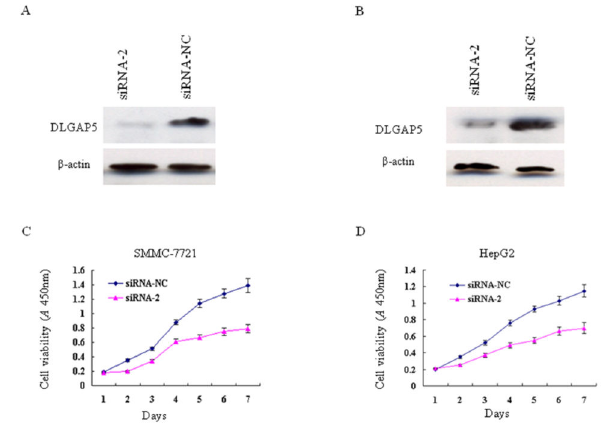
Figure 4. Effect of DLGAP5 silencing on HCC cell growth. (A and B) western blot confirmation of DLGAP5 knockdown in SMMC-7721 (A) and HepG2 (B) cells via transient transfection with siRNA2. siRNA-NC was used as the control. (C and D) The growth curves of the SMMC-7721 (C) and HepG2 (D) cells after DLGAP5 knockdown by siRNA2 were plotted based on the CCK-8 assay. siRNA-NC served as a control. The experiments were repeated at least three times, and the data points represent the average values of triplicate wells, with standard deviations (SDs) included for each mean value. doi: inhibition of cell invasion through a Matrigel barrier when fibronectin was used as an attractant ( P <0.01; Figure 5C and 5D). Furthermore, we performed the cell adhesion assay to explore the effect of DLGAP5 gene on the ability of cell